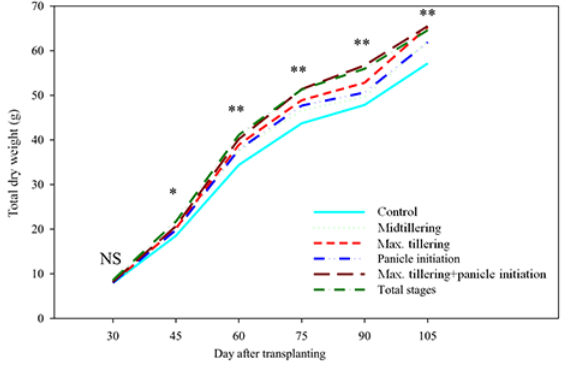
Figure 4 Effect of the foliar application of nutrients on the total dry weight in different growth stages. NS, *, and ** mean not significant and significant at 5% and 1% probability level,